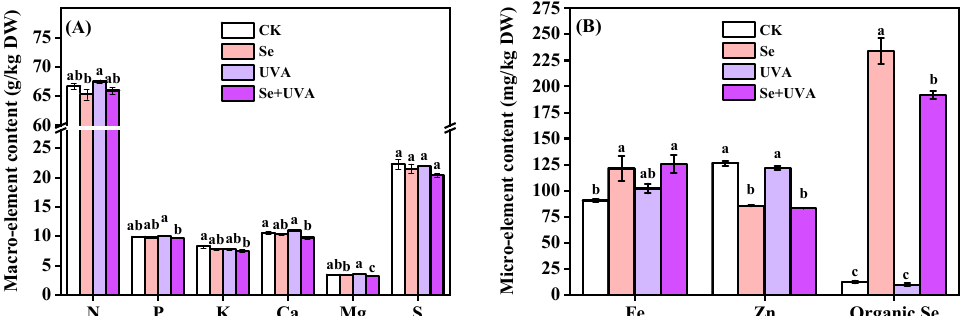
Figure 7. The contents of macroelement ( A ) and microelement ( B ) content in broccoli microgreens under Se (100 µ mol/L Na 2 SeO 3 ), UVA (40 µ mol/m 2 /s), and combined treatments. The vertical bars indicate standard errors, n = 3. Different lower-case letters above the bars indicate significant differences between treatments by Duncan’s multiple range test at a level of 0.05. Table 6. The interaction effects of Se and UVA on mineral elements content of broccoli microgreens. Interaction